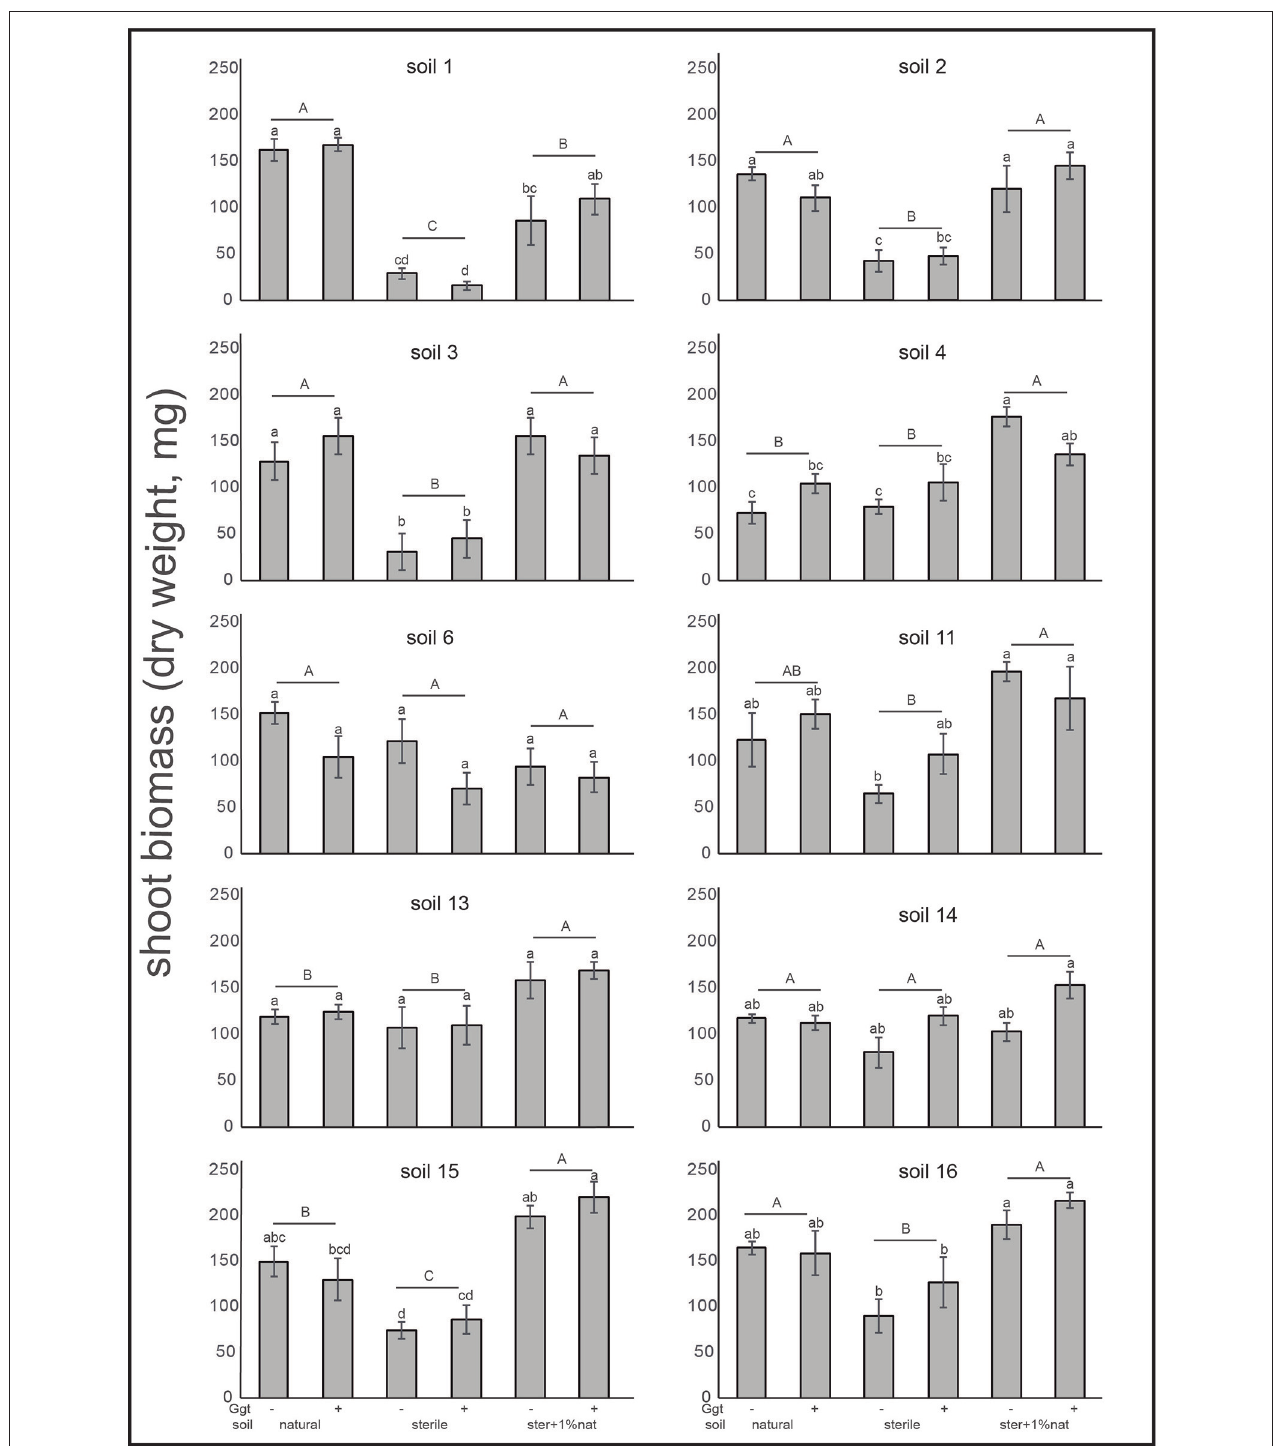
FIGURE 6 | Shoot biomass (dry weight) of wheat plants from suppressive soil assay in greenhouse. Treatments were: natural soil (natural), sterile soil (sterile), and sterile soil supplemented with 1% of natural soil (ster + 1% nat)- and inoculated ( + ) or not ( − ) by Ggt ( n = 5). Tukey’s test was used to compare treatments means, values followed by the same letter do not differ at P ≤ 0.05 ( n =